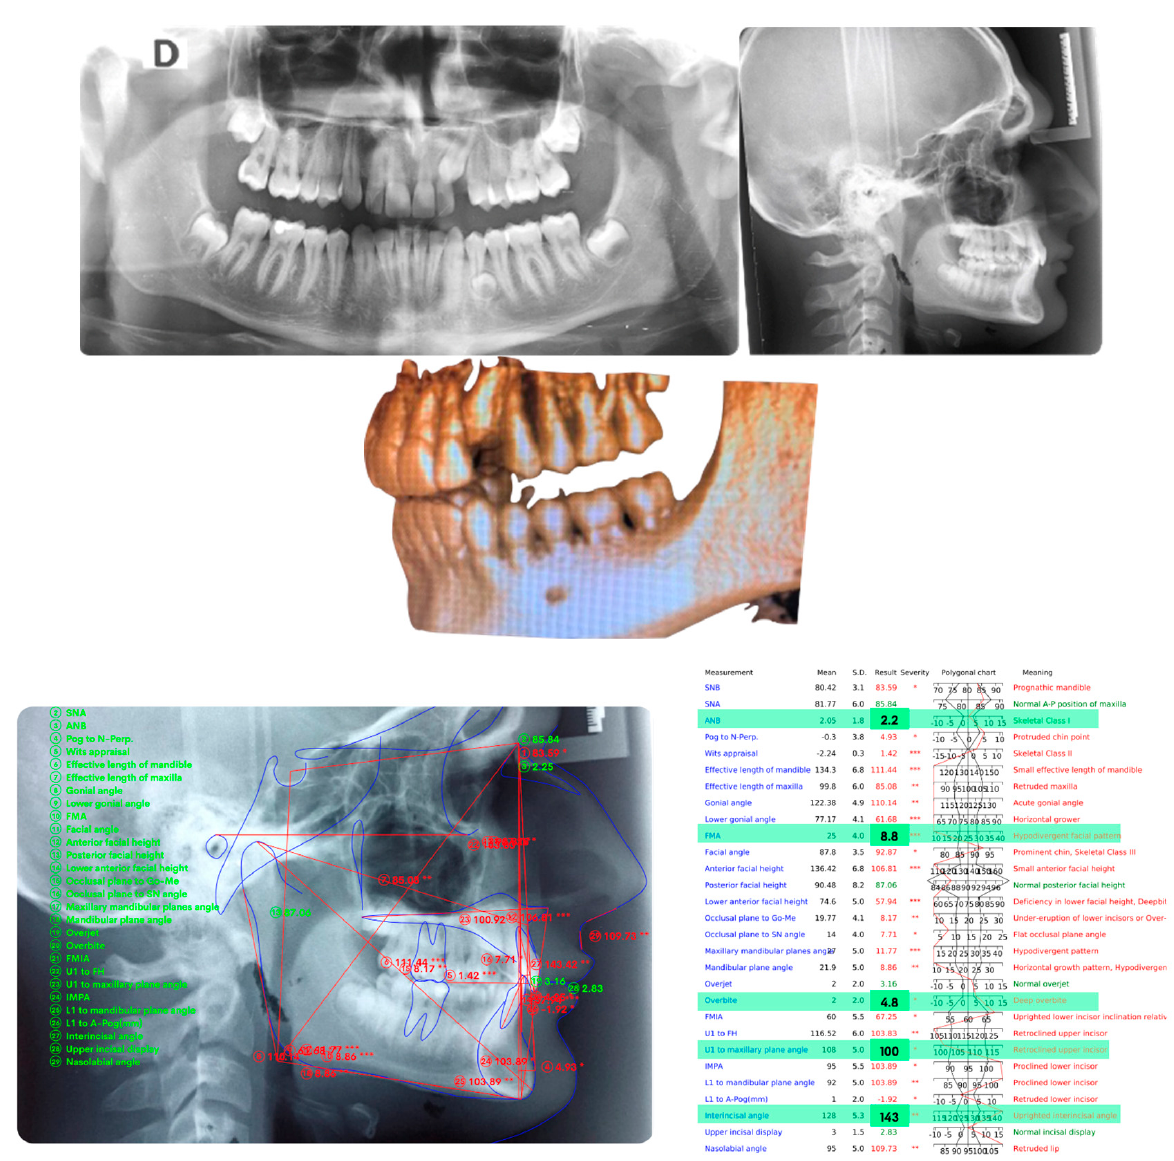
Figure 2. Cephalometric analysis, panoramic and CBCT of the first patient. Lateral X-rays confirming a Class I skeletal and dental malocclusion with deep bite.